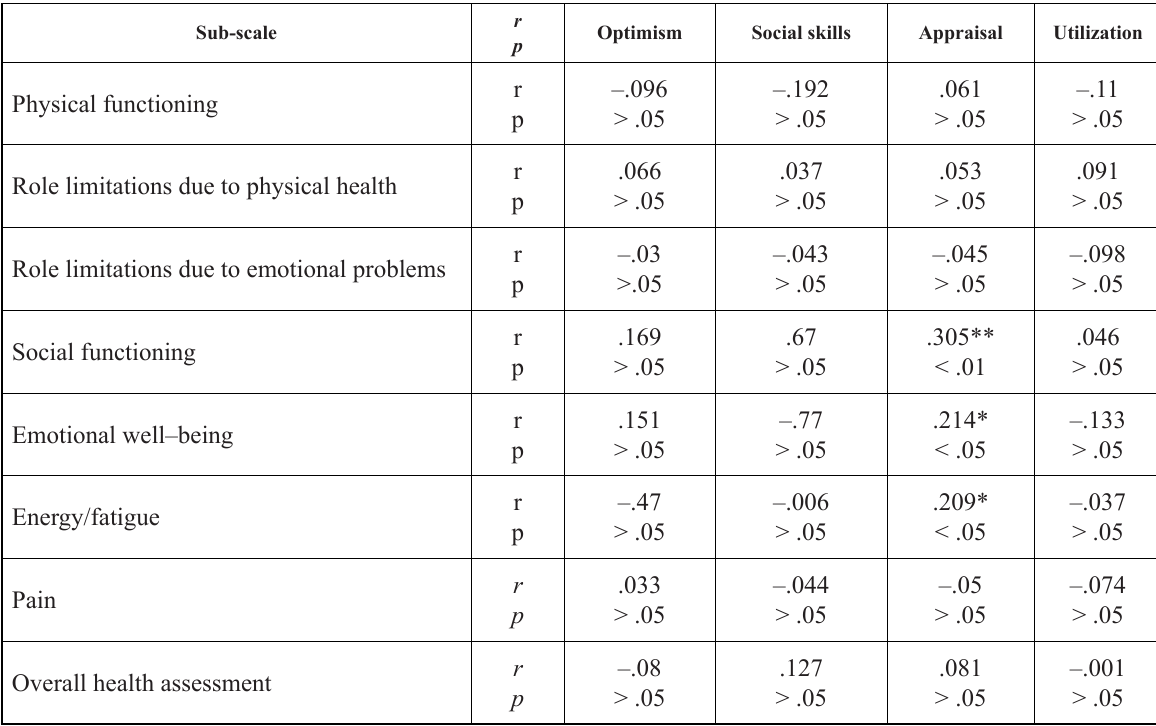
Table 4. Correlations between scores coefficients of teacher subjective quality of life and self-report of emotional